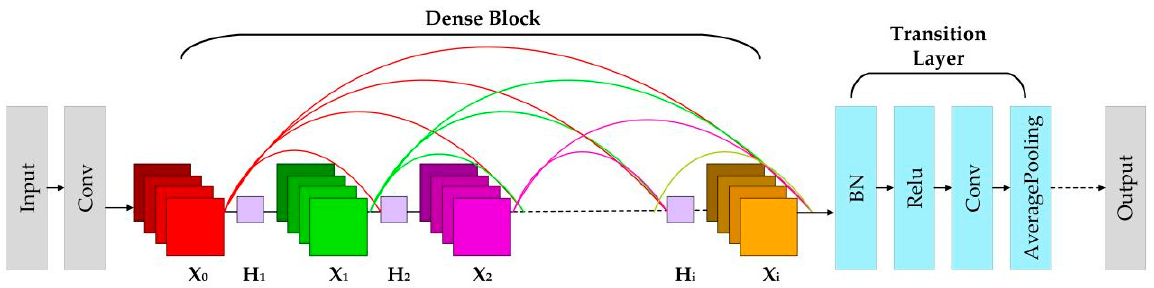
Figure 7. Structure diagram of DenseNets.